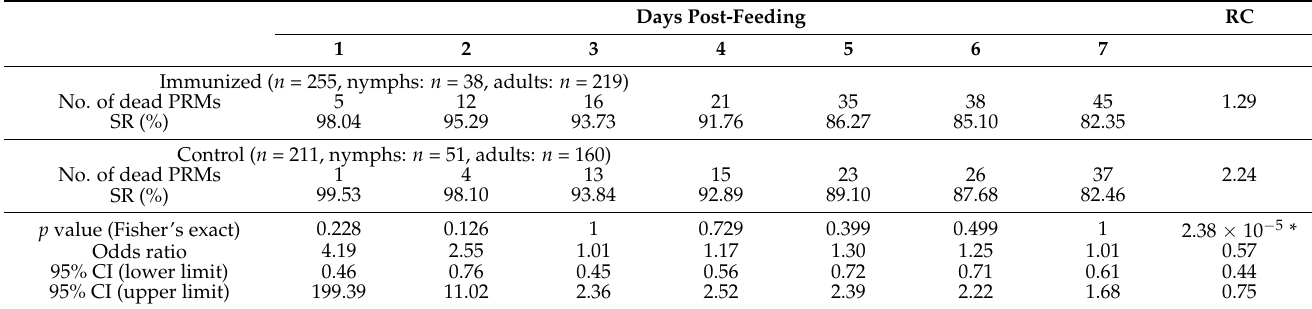
Table 1. Summary of the anti-PRM property of Dg-Cys -his immunization (first experiment). Days Post-Feeding RC